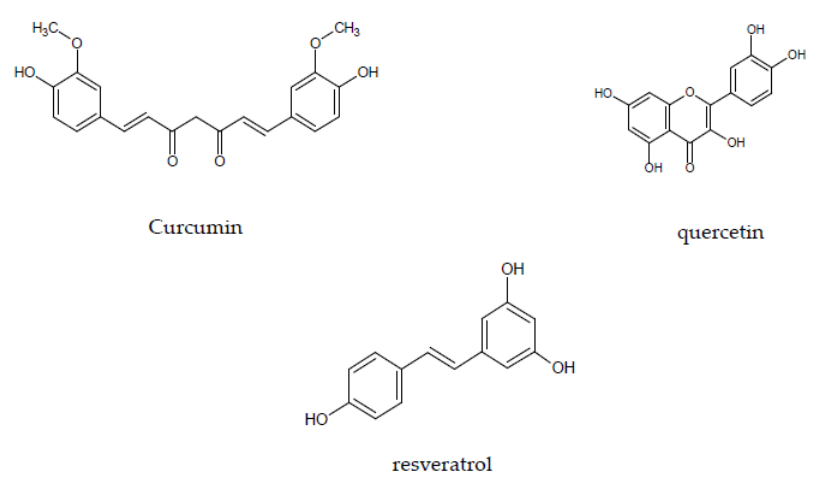
Figure 2. Chemical structures of curcumin, quercetin, and